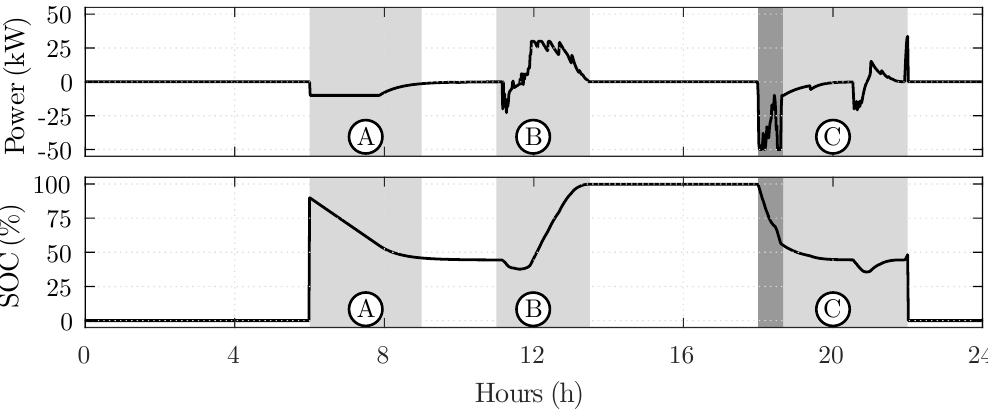
Figure 9. EV instantaneous power ( left ) and corresponding SOC ( right ), with the charging mode and the connection period. The modes are represented by: 1, ULTRA; 2, FAST; 3, ECO; and 4, V2G.